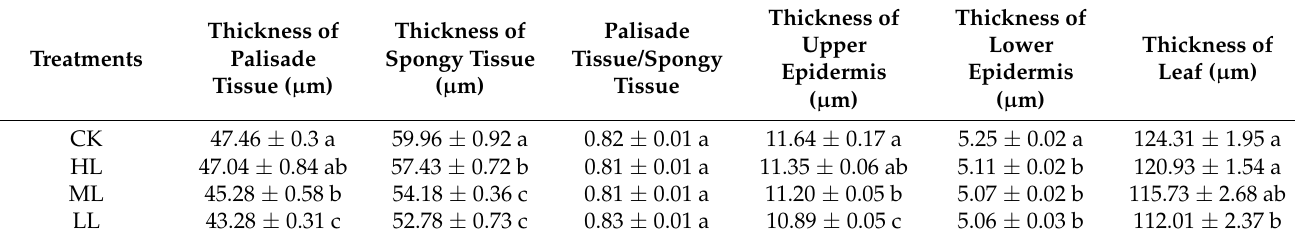
Table 1. The anatomical structure of J. regia f. luodianense seedlings leaves under different light intensities. Thickness of Treatments